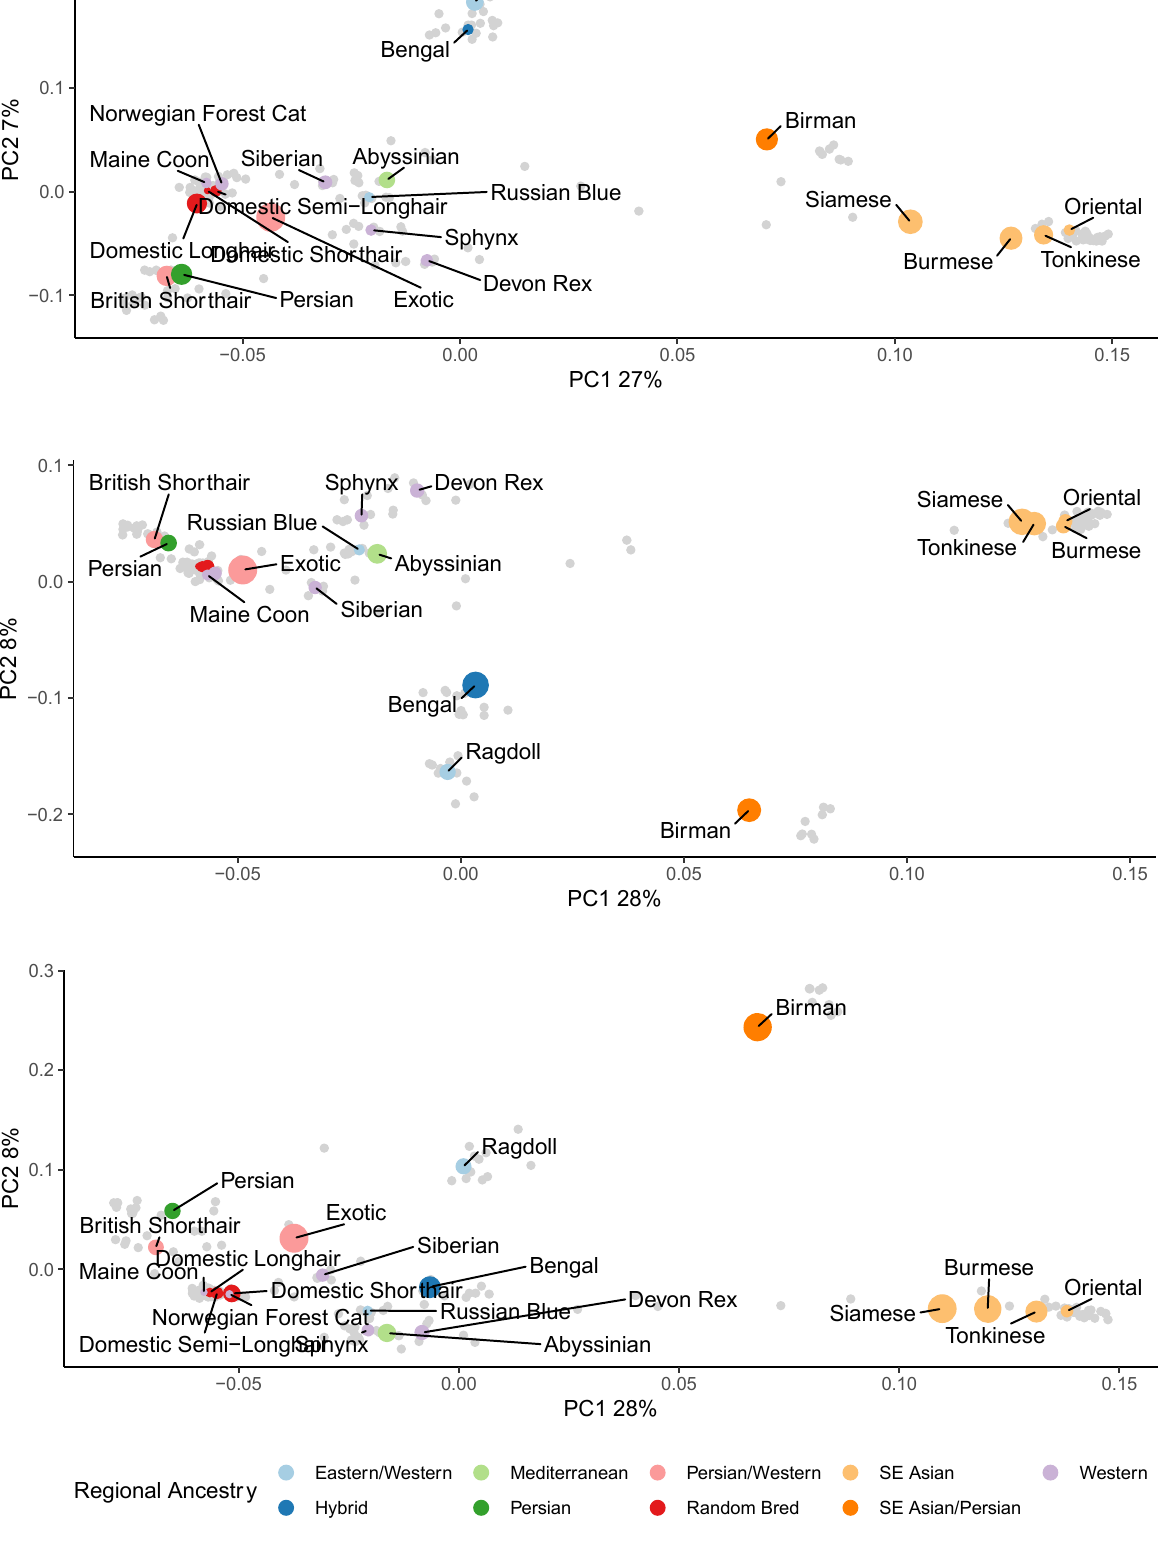
Figure A3. PCA for three additional balanced datasets (randomly chosen). Comparison of panel A to other panels’ PC2 axes reveals instability in the ancestry described by this PC.